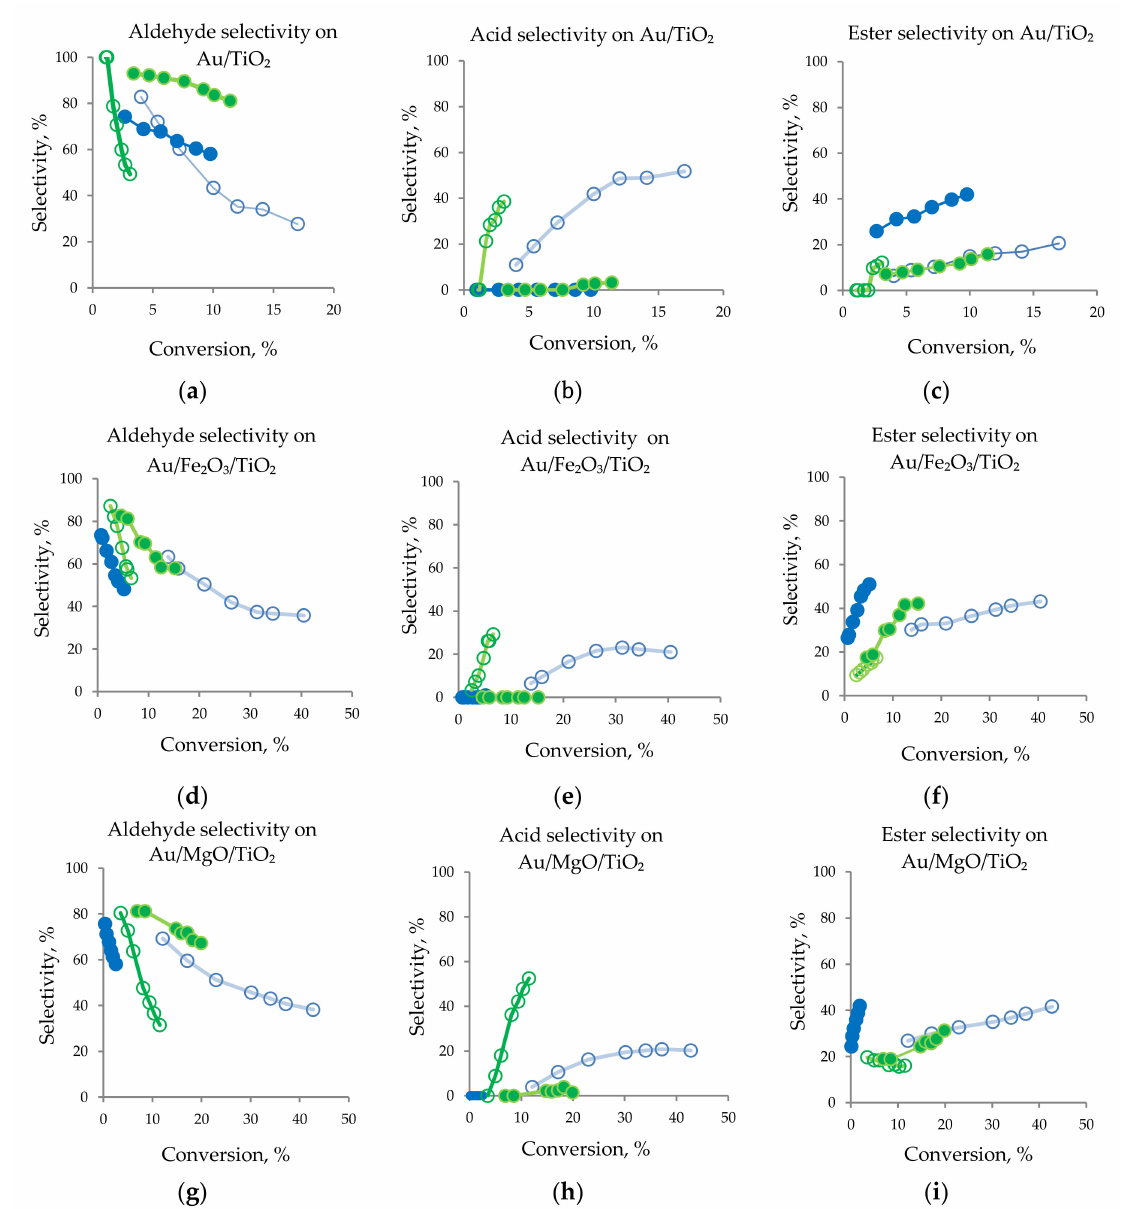
Figure 2. E ff ect of gold loading and pretreatments on the oxidation of n -octanol on Au / M x O y / TiO 2 (M x O y = Fe 2 O 3 , MgO) catalysts. Products selectivity evolution with conversion for Au / TiO 2 ( a – c ), Au / Fe 2 O 3 / TiO 2 ( d – f ) and Au / MgO / TiO 2 ( g – i ) is shown. Green lines: results after hydrogen pretreatment, blue lines: after oxygen pretreatment. Catalysts Au contents: hollow symbols show catalysts with 0.5% Au; full symbols with 4%